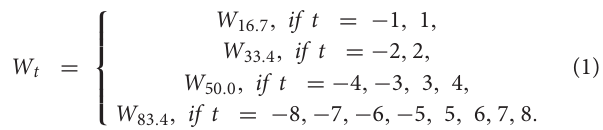
only obtain the average weight in the multi-frame external noise